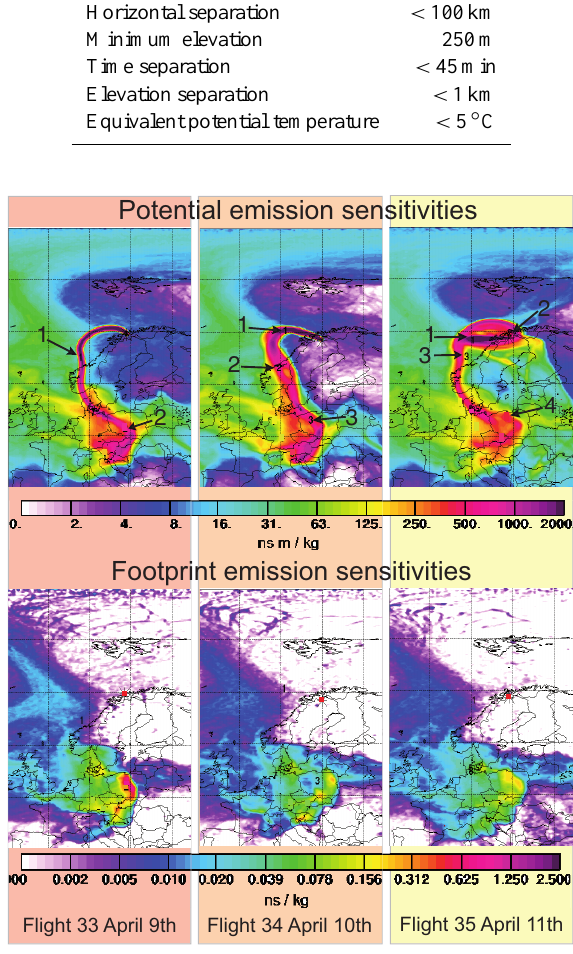
Fig. 2. FLEXPART column-integrated potential emission sensitivi- ties (PES, top) and footprint emission sensitivities (FPES, bottom) for the anthropogenic air mass sampled during the flights on 9, 10 and 11 April 2008. Numbers indicate the air mass age in days at the location pointed by corresponding black arrows. On FES maps, red squares indicate the aircraft location, used as a starting point to run FLEXPART.